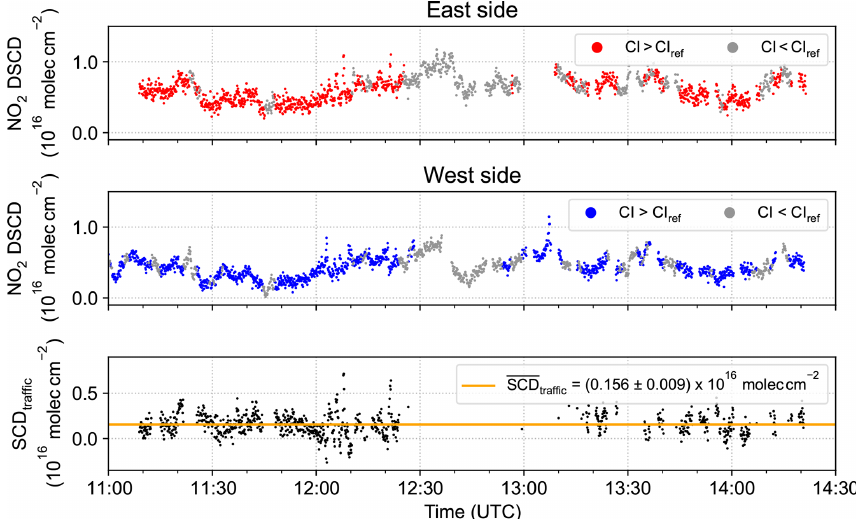
Figure B3. Analysis result of the NO 2 DSCDs for both sides (blue: west side, upwind; red: east side, downwind) with applied cloud filter based on the colour index (CI; intensity ratio 320nm / 440nm). The grey data points are filtered out. The resulting difference SCD traffic is depicted in the lowermost panel, yielding slightly lower NO 2 SCDs compared to the unfiltered